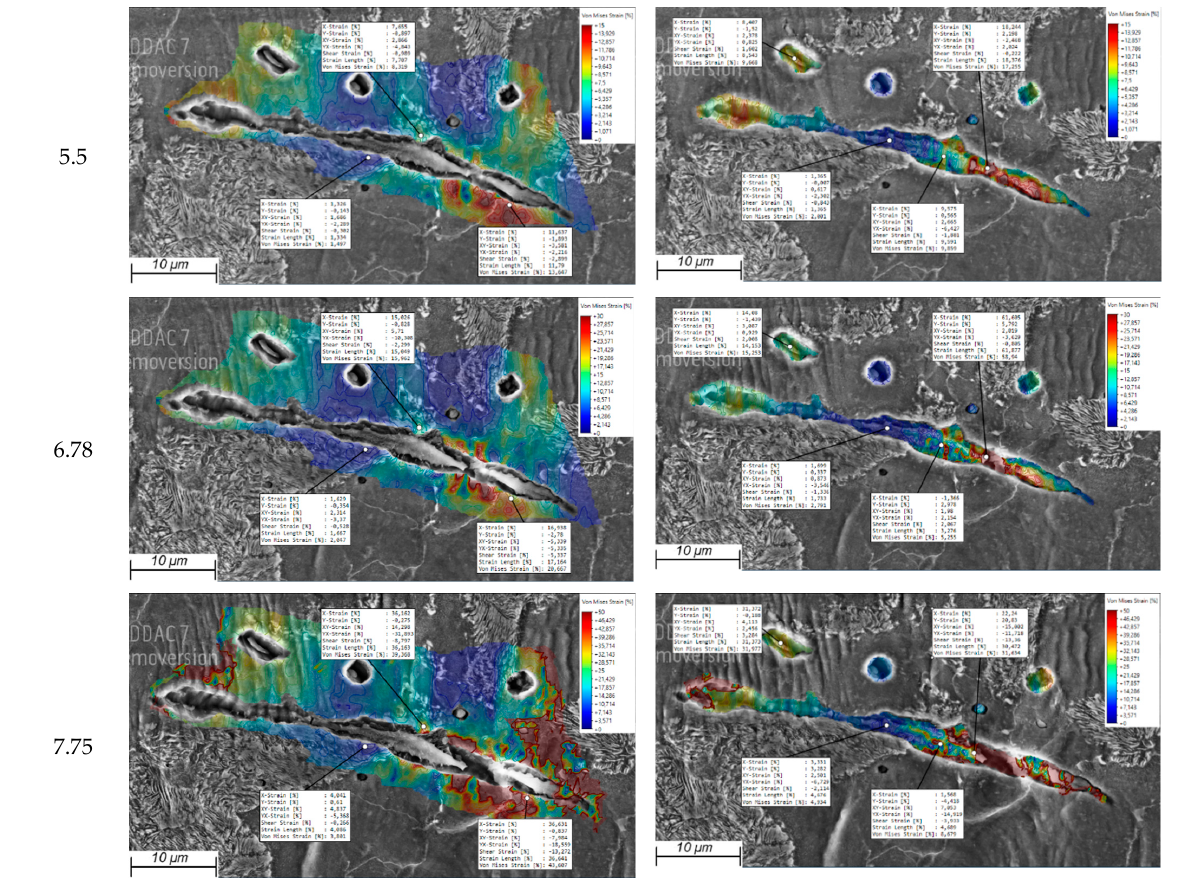
Figure A10. Local strain measurement overlaid on SEM micrographs.